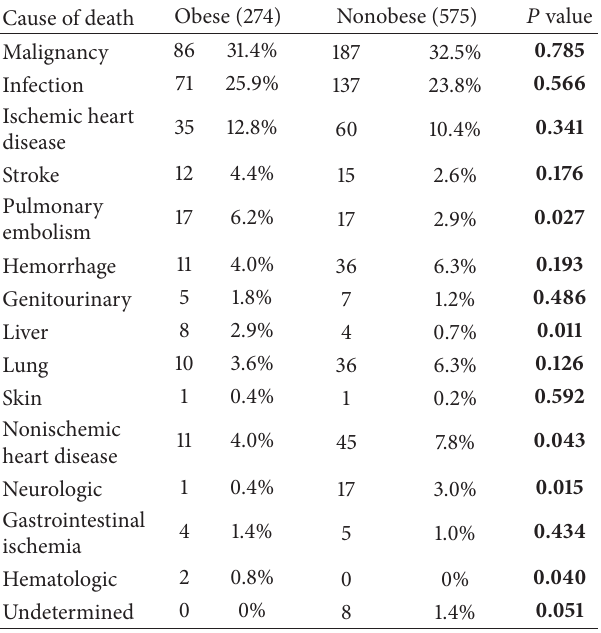
Table 2: Comparison of the cause of death in obese and nonobese individuals.